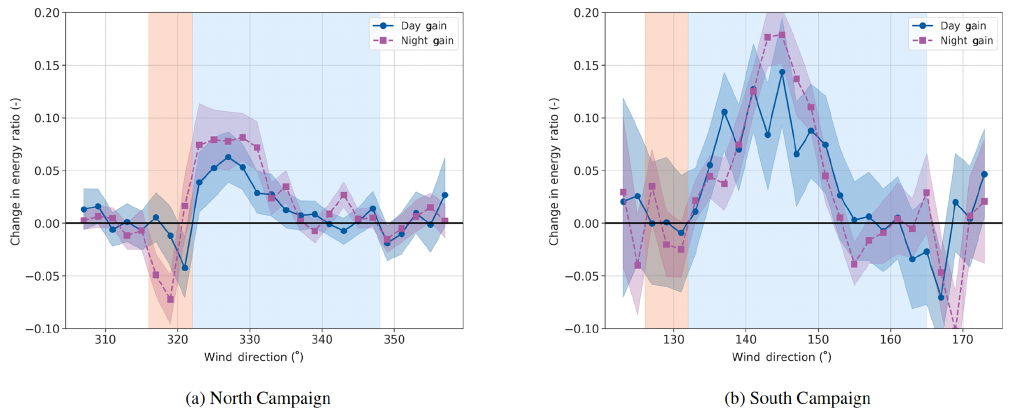
Figure 9. Comparison of the change in the energy ratio of T3 for daytime versus nighttime conditions.